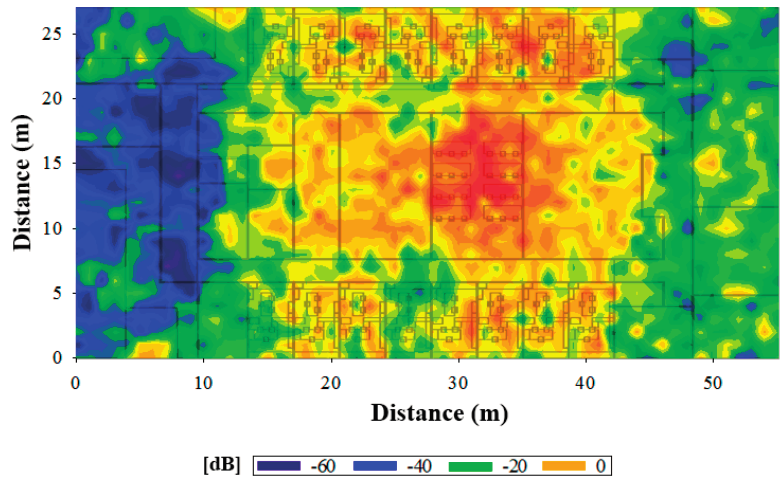
Figure 8. SNR map with the interference caused by all the antennas over the third antenna acting as valid transmitter.